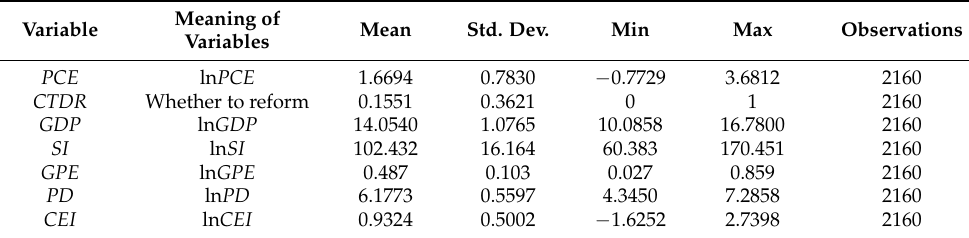
Table 2. Descriptive statistical analysis of